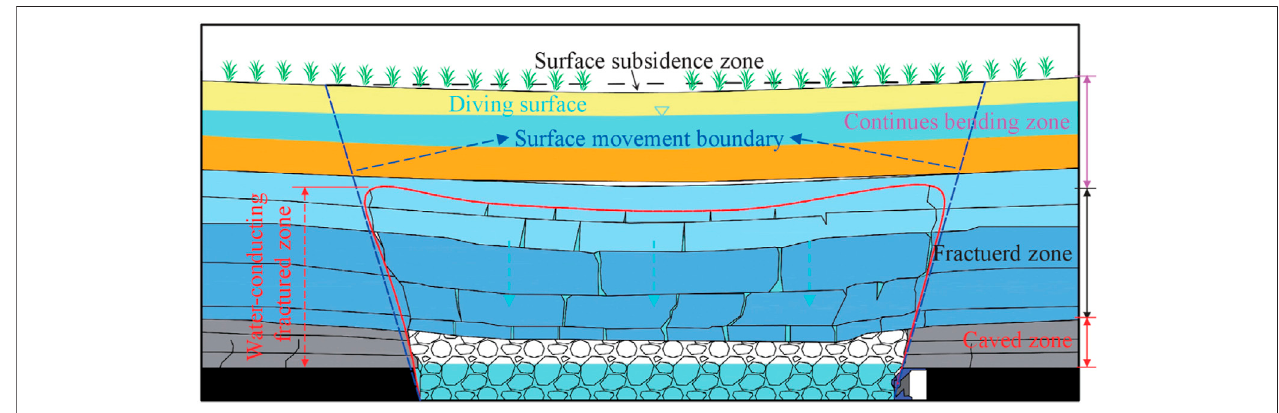
FIGURE 1 | Division zones of the coal-roof strata after